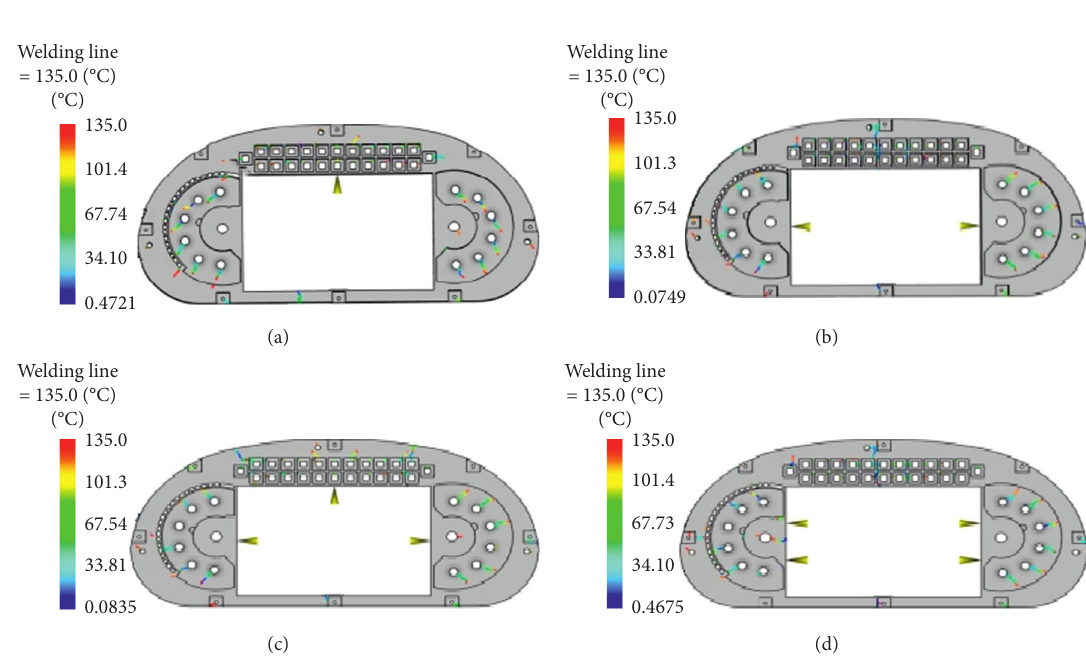
Figure 7: Welding line of different gate